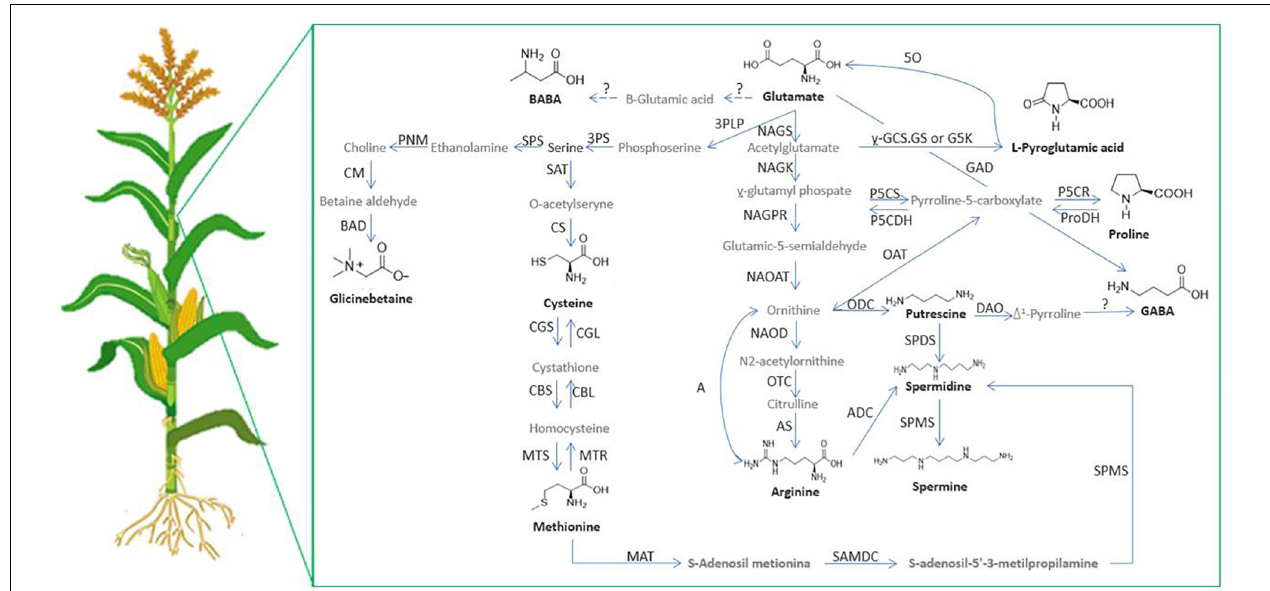
FIGURE 4 | Relationships between proteinogenic/non-proteinogenic amino acids and polyamines in plants. 3PLP, 3-phosphoserine aminotranferase; 3PS, P-serine phospatase; 5O, oxoprolinase; A, arginase; ADC, arginine decarboxylase; AS, argininosuccinate synthase; BAD, betaine aldehide deshidrogenase; CBL, cystathionine β -lyase; CM, choline monooxigenase; CS, cysteine synthase; CGL, cysthathionine-y . -lyase; CGS, cystathionine y . -synthase;CBS, cystathionine β -synthase; DAO, diamine oxidase; y . -GCS, y . -glutamylcysteine synthetase; GAD, glutamate decarboxylase; GS, glutamine synthetase; G5K, glutamate 5-kinase; MAT, methionine adenosine transferase; MTS, methionine synthase; MTR, methyonine reductase; NAGK, N-acetylglutamate kinase; NAGPR, N-acetylglutamate-5-phosphate reductase; NAGS,N-acetylglutamate synthase; NAOAT, N-acetylornithine aminotransferase; NAOD, N-acetylornithine deacetylase; OAT, ornithine δ -aminotransferase; ODC, ornithine decarboxylase; OTC, ornithine transcarbamoylase; ProDH, proline dehydrogenase; P5CDH, (cid:49) 1-pyrroline-5-carboxylate dehydrogenase; P5CR, (cid:49) 1-pyrroline-5-carboxylate reductase; P5CS, (cid:49) 1-pyrroline-5-carboxylate synthetase; PNM, phosphoethanolamine N-methyltransferase; SAMDC, S-adenosylmethionine decarboxylase; SAT, Serine O -cetyltranserase; SPDS, spermidine synthase; SPS, serine-phosphoethanolamine synthase; PAO, polyamine oxidase; SPMS, spermine synthase.